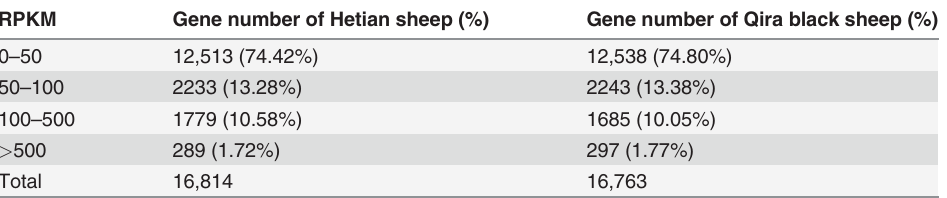
Table 2. Gene expression and annotation by